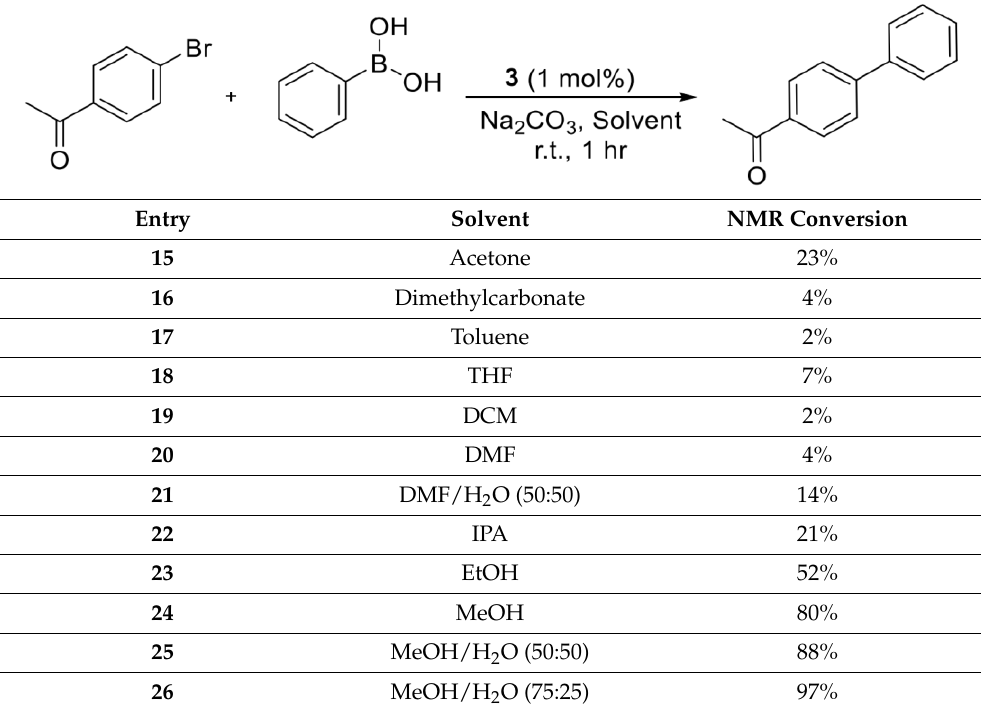
Table 3. Solvent screen results with solvent used and NMR conversion.